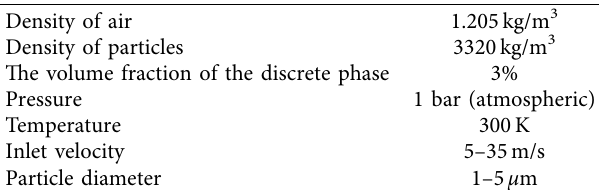
Figure 1: Schematic and the axial sections of the test cyclone [16]. Table 1: Boundary conditions. Table 2: Grid sensitivity